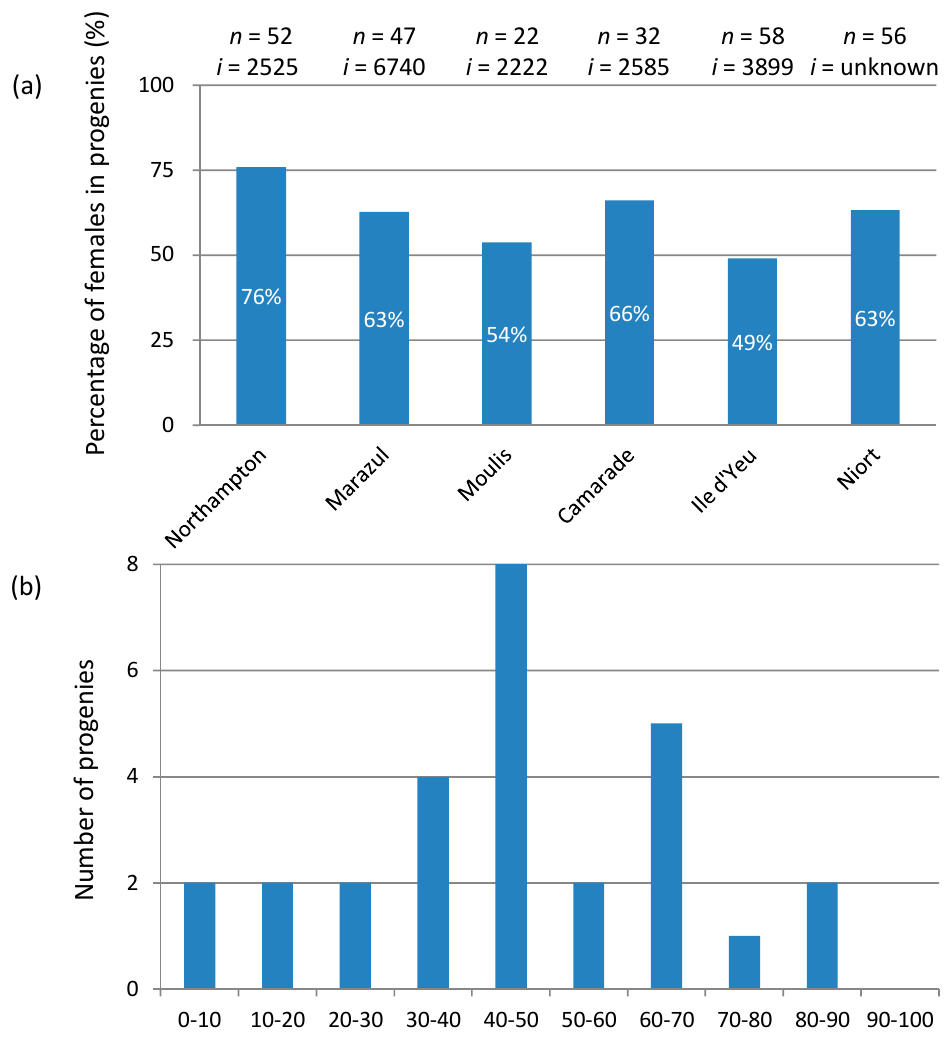
Figure 3. Variations in female percentage in progenies of Armadillidium vulgare females carrying the f element at different population levels. ( a ) Variation among six natural populations (data from [59,62]); n is the number of progenies, while i is the total number of individuals. The locations of the populations were the United Kingdom (Northampton), the Canary Islands in Spain (Marazul), and France (Moulis, Camarade, Ile d’Yeu and Niort). The average female percentage across the six populations is 62%. ( b ) Variation within a single population. Distribution of 28 progenies from females sampled in Niort, France (data from [62]), according to female percentage.